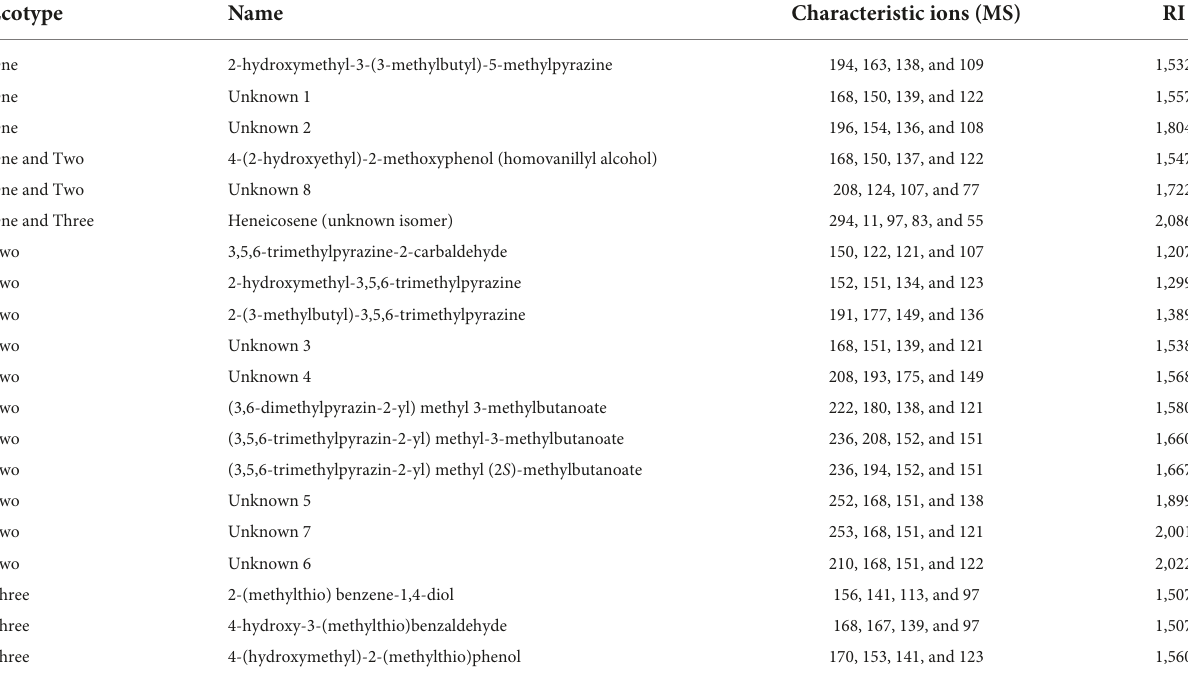
TABLE 1 Characteristic ions and retention indices (RI) of compounds from Weinstein et al. (2022) that were used to assign ecotypes.